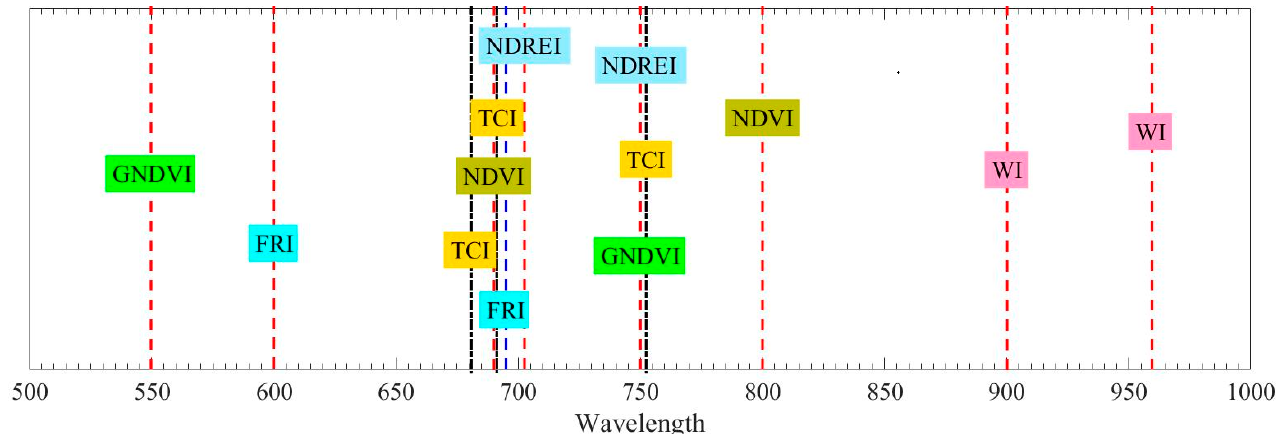
Figure 3. Corresponding wavelength of the spectral profiles employed in the determination of the indexes.